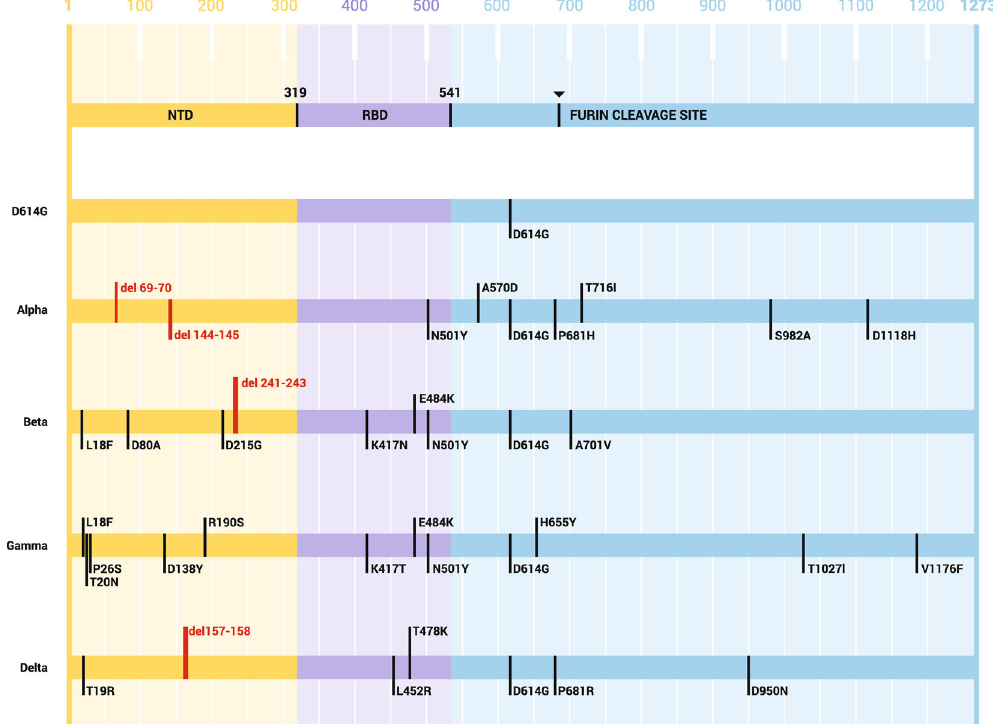
Fig. 1 Amino-acid changes in the S protein of the Alpha, Beta, Gamma, and Delta variants of concern of SARS-CoV-2. NTD N-terminal domain, RBD receptor-binding